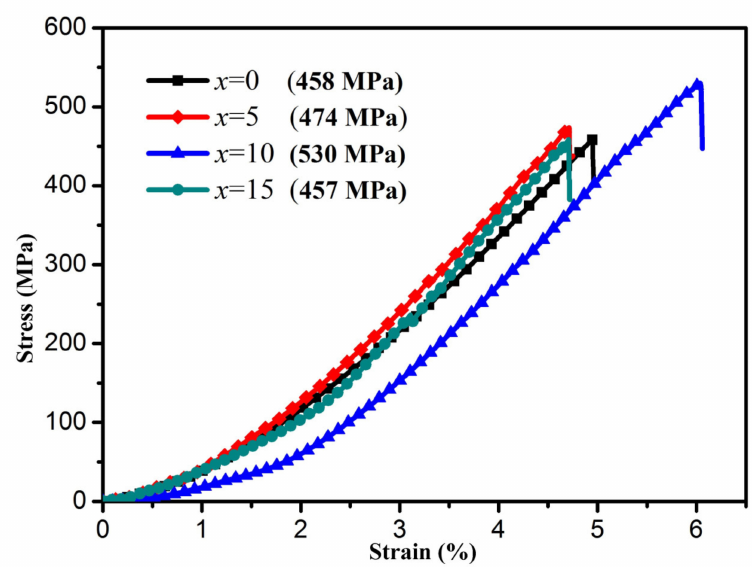
Figure 4. Stress–strain curves for the LaFe 11.6 Si 1.4 / x wt.%Ce 2 Co 7 ( x = 0, 5, 10 and 15) composites sintered at 1373 K for 6 h. Table 3. Porosity, thermal conductivity, and mechanical properties of LaFe 11.6 Si 1.4 / x wt.%Ce 2 Co 7 ( x = 0, 5, 10 and 15) composites sintered at 1373 K for 6 h. Sample Porosity (%) λ (W/m · K) ( σ bc ) max (MPa) Strain (%) Binder